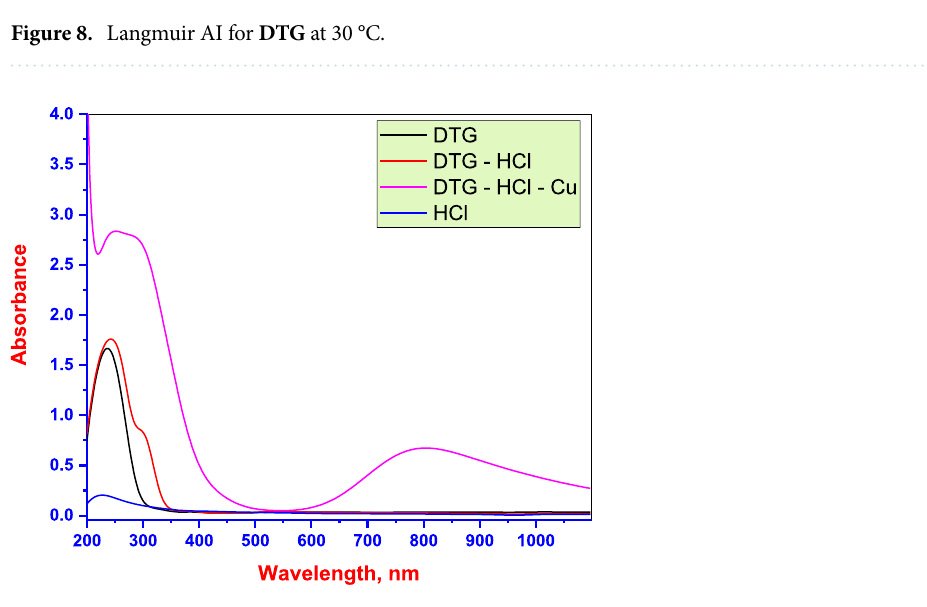
Figure 9. UV–visible spectra for the DTG (black color), 0.5 M HCl solution (blue color), 0.5 M HCl solution containing DTG (red color) before, and (violet color) after 48 h of copper immersion at 30